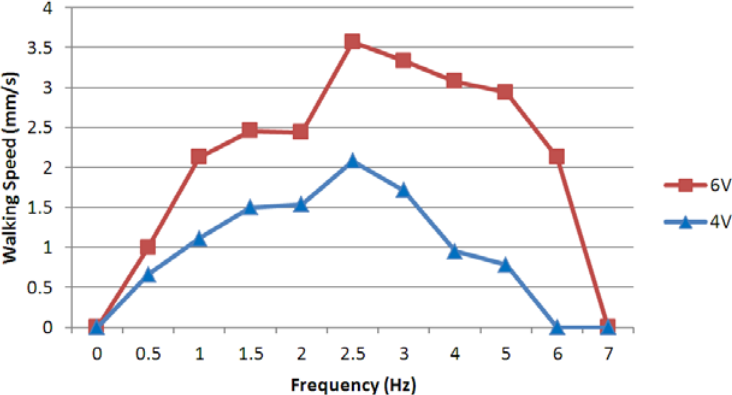
Figure 21. Experimental walking speeds with different frequencies.